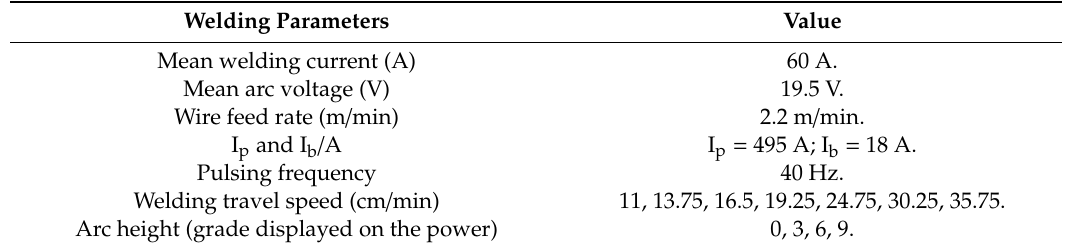
Table 2. Welding process